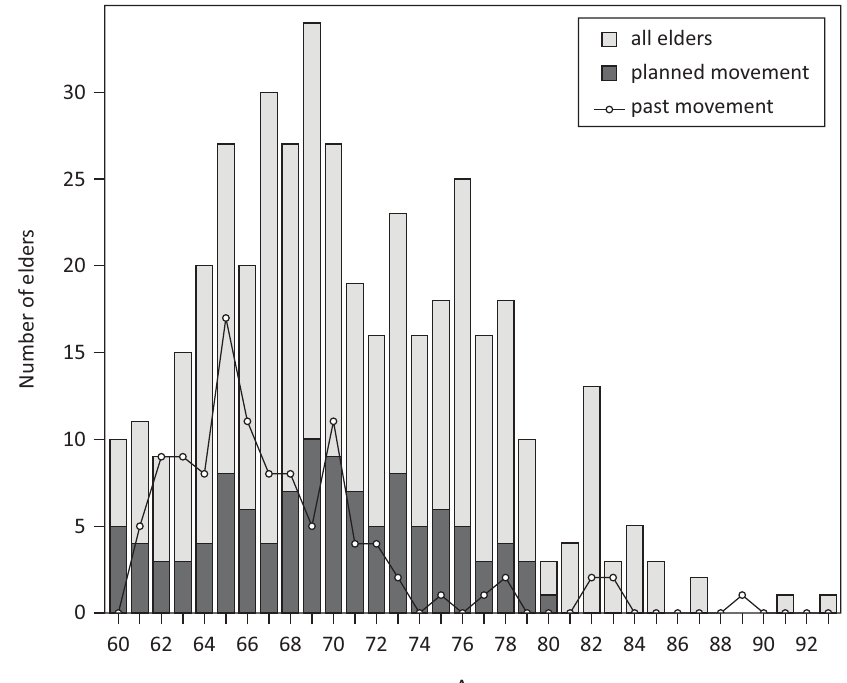
Figure 2. Total age distribution of the respondents, the age distribution of people who plan a movement, and distribution of moving age for past